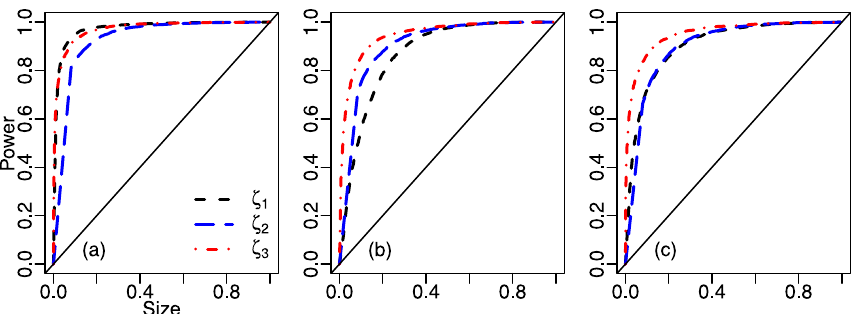
Fig 3. Size-power plots, UW ð ω ; ϕ Þ , n = 100; panel (a): UW ð 0 : 2 ; 5 Þ , panel (b): UW ð 0 : 5 ; 5 Þ , panel (c): UW ð 0 : 75 ; 5 Þ .